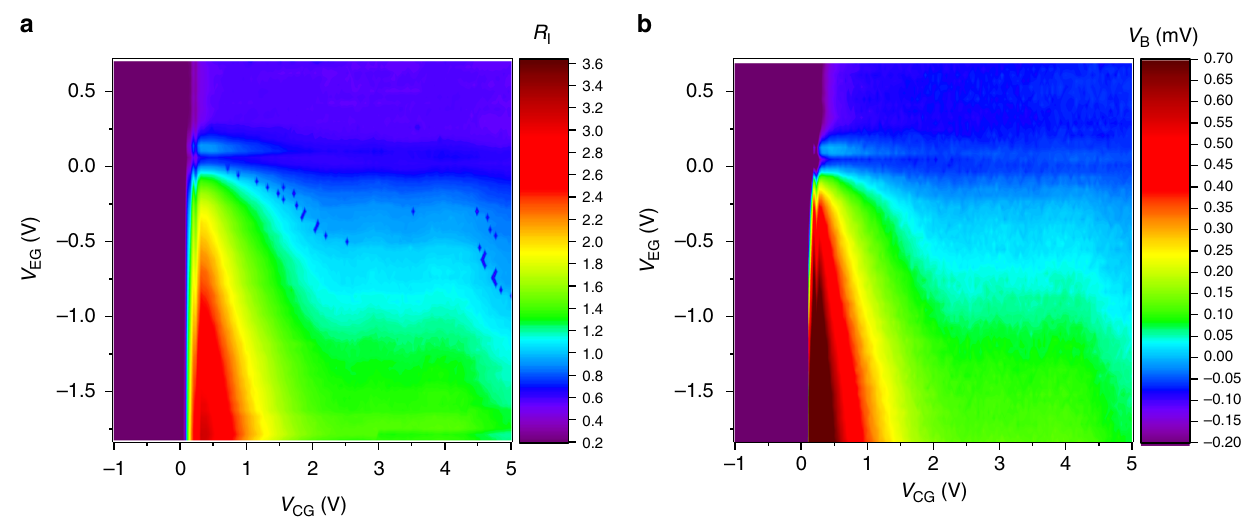
Fig. 2 Color plot of the device characteristics in the V CG and V EG plane. a R I with the base terminal grounded ( V B = 0 V). Blue dots seen in the fi gure are the random telegraph noise presumably due to a single defect at the Si/SiO 2 interface. b V B with the base terminal current biased at I B = 0 A